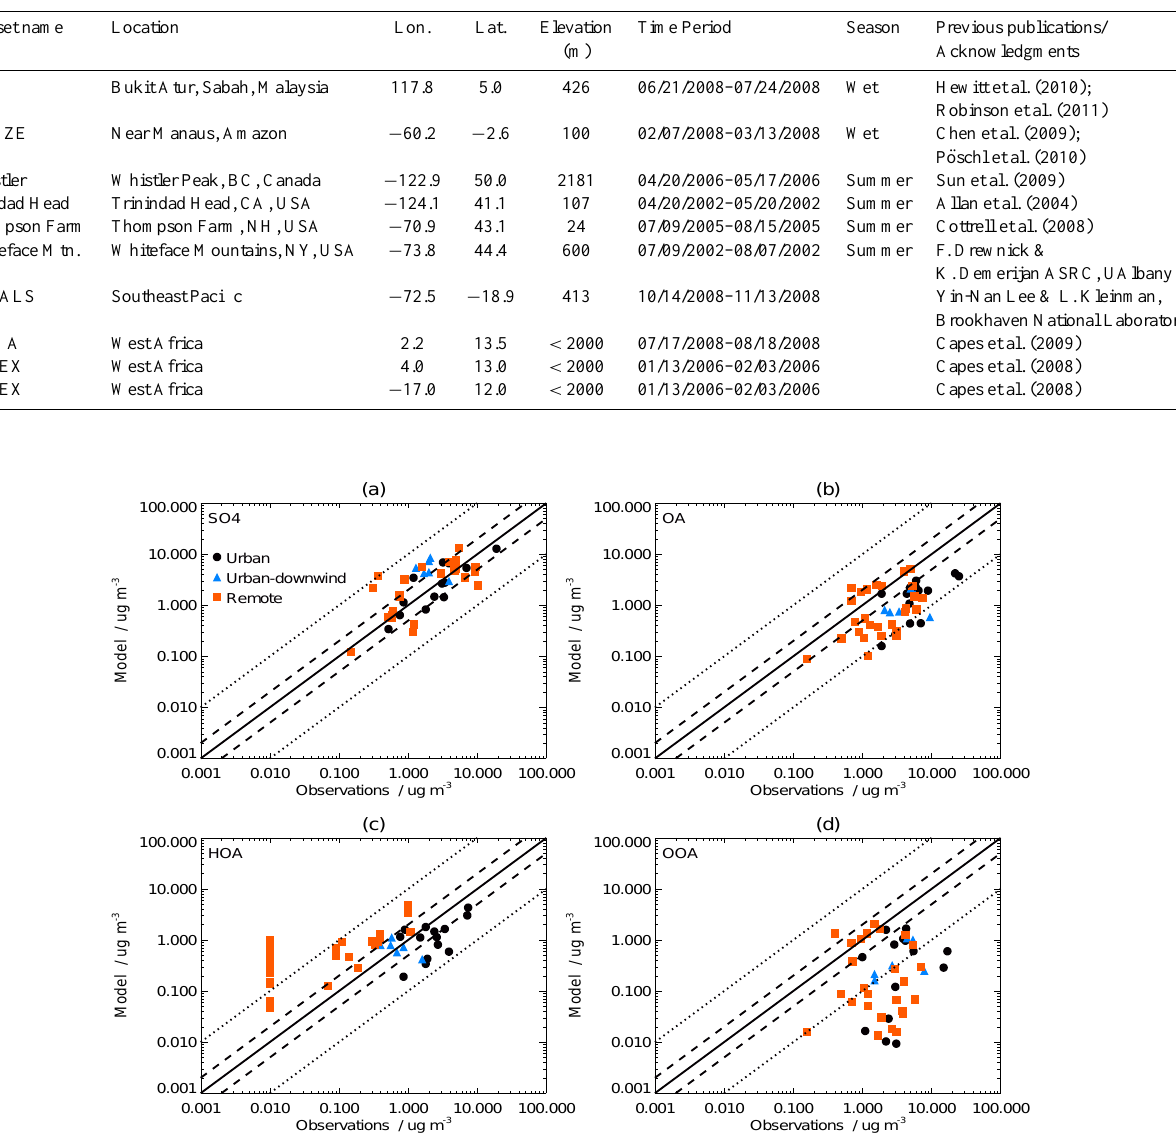
Fig. 2. Scatterplot of simulated (GLOMAP, simulation 1) versus observed (AMS) (a) sulfate, (b) OA, (c) HOA and (d) OOA. Model includes SOA from monoterpenes (26% SOA yield, 32.3Tg(SOA)a − 1 ) . Observation locations are classified as urban, urban-downwind and rural/remote as in Zhang et al. (2007). The 1:1 line (solid), 2:1 lines (dashed) and 10:1 lines (dotted) are indicated. Model-observation statistics are shown in Table 2. Observational constraints limit identification of HOA at very low concentrations. We assume a lower limit for HOA of 0.01µgm − 3